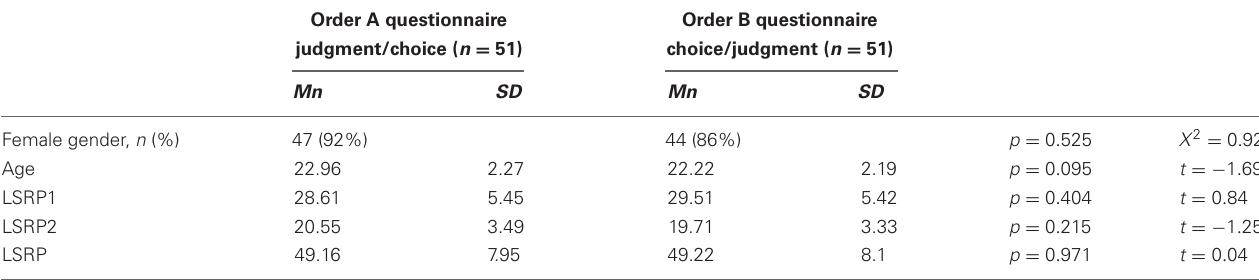
Table 1 | Participant characteristics based on the type of questionnaire (judgment/choice vs. choice/judgment).